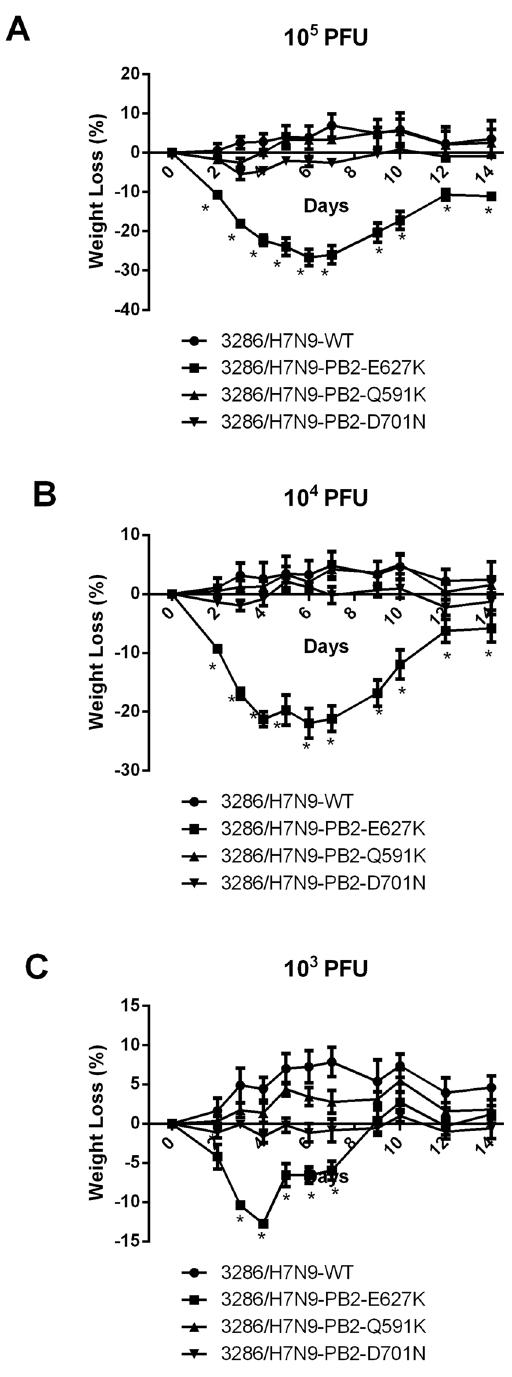
Figure 3. The weight change of the mice infected with the duck 3286/H7N9 and its PB2 mutants. Female BALB/c mice were infected intranasally with ( A ) 10 5 PFU ( B ) 10 4 PFU ( C ) 10 3 PFU of the indicated viruses. The virus infected mice were monitored for 14 days and their weight were determined. Results from each group and each time point are expressed as mean ± SD of six infected mice from two independent experiments. The values were statistically analyzed by two tailed, non-paired t-test. * p <